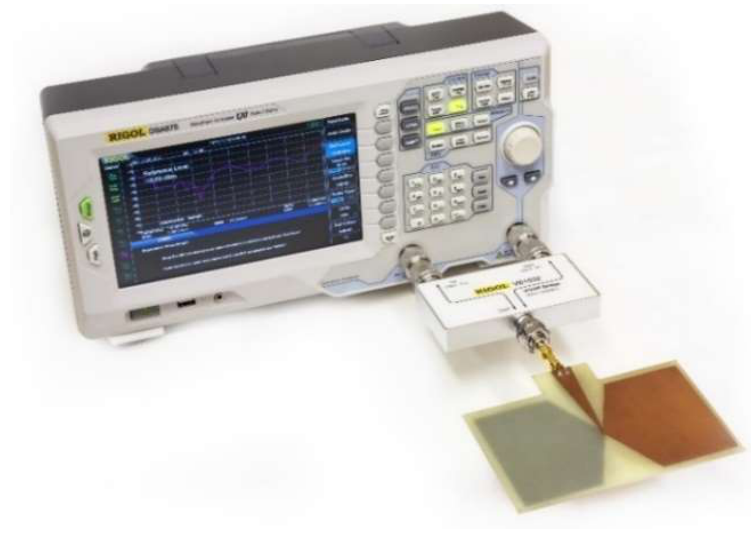
Figure 11. Measurement of S11-parameter using the Spectrum analyzer.